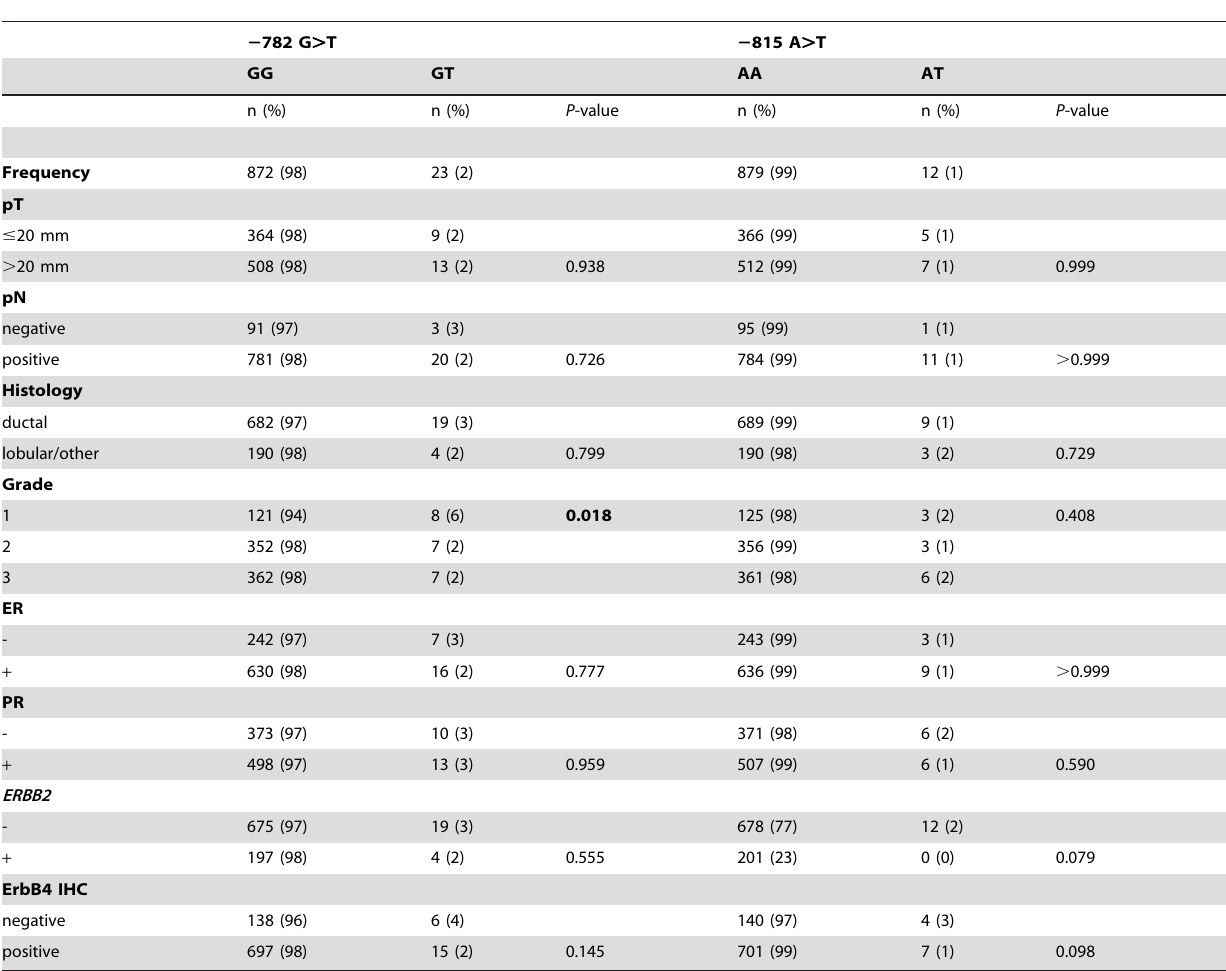
Table 1. Clinicopathological features of patients harboring ERBB4 variants 2 782G . T or 2 815A .